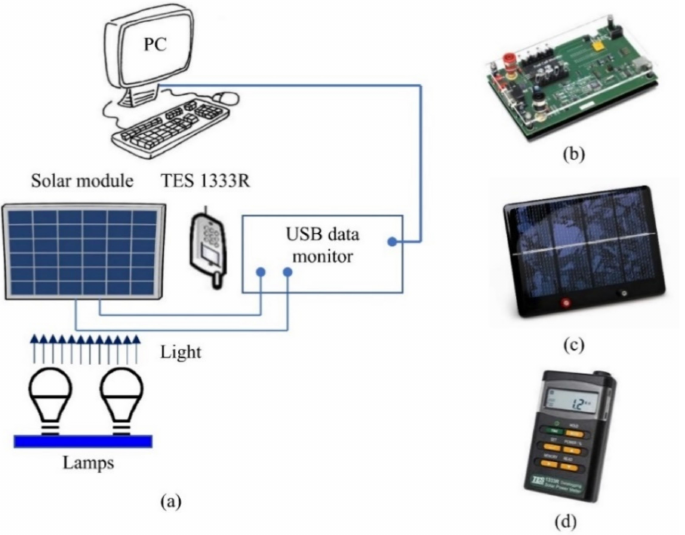
Figure 25. Experimental setup: ( a ) connection diagram, ( b ) USB data monitor, ( c ) solar module, and ( d ) device for insolation